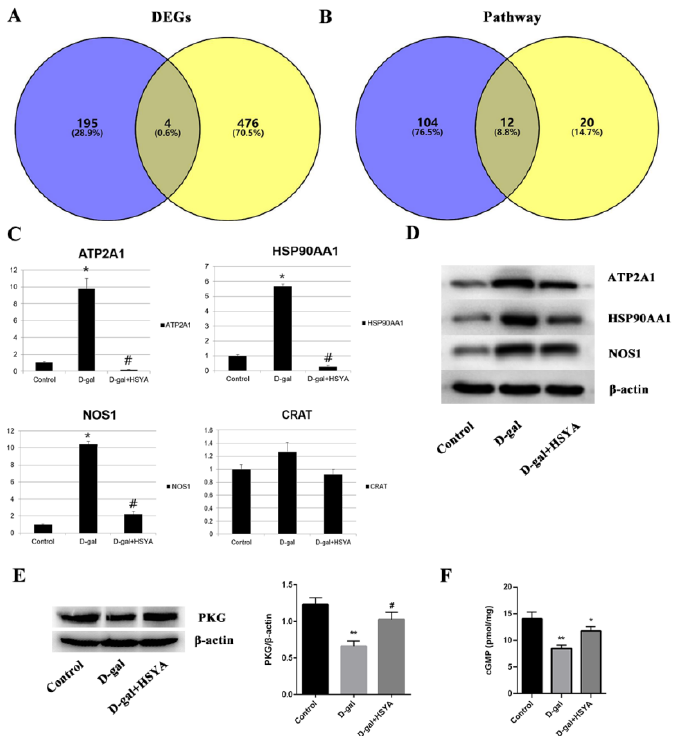
Figure 7. Preliminary verification of the mechanism of HSYA delay of LA. Venn diagram of ( A ) key targets and ( B ) signaling pathways combining network pharmacology prediction and transcriptomic analysis. qRT-PCR ( C ) and Western blot ( D ) to detect the expressions of four targets in mouse liver tissue. ( E ) PKG levels in the livers of mice from each group. ( F ) Expression of cGMP in the livers of mice was observed by ELISA. D-gal group compared with control group, * p < 0.05, ** p < 0.01; D-gal group with HSYA compared with D-gal group, # p < 0.05; data points represent means ± SD (n = 3); error bars indicate SD.